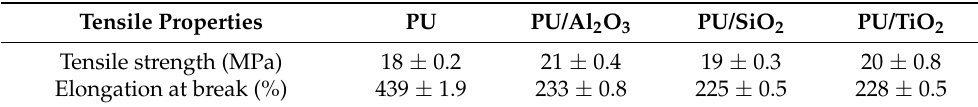
Table 3. Mechanical properties of different PU/ceramic composite films.